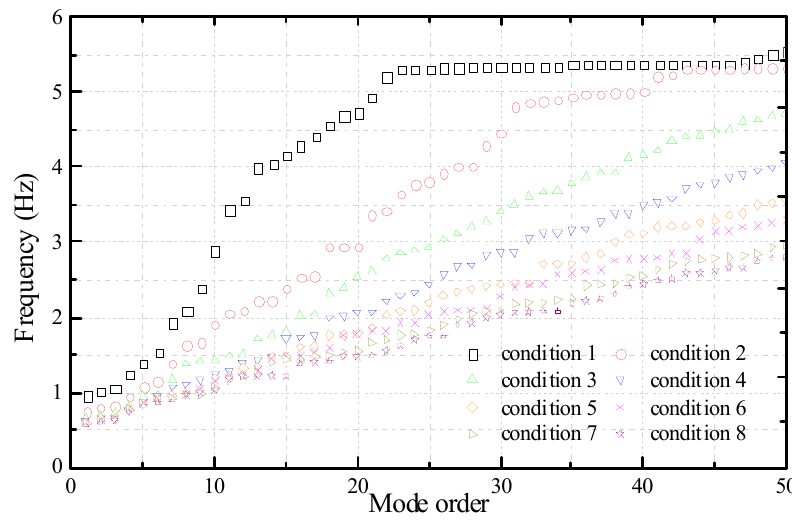
Figure 7. Frequency distribution of the first fifty modes under each working condition.